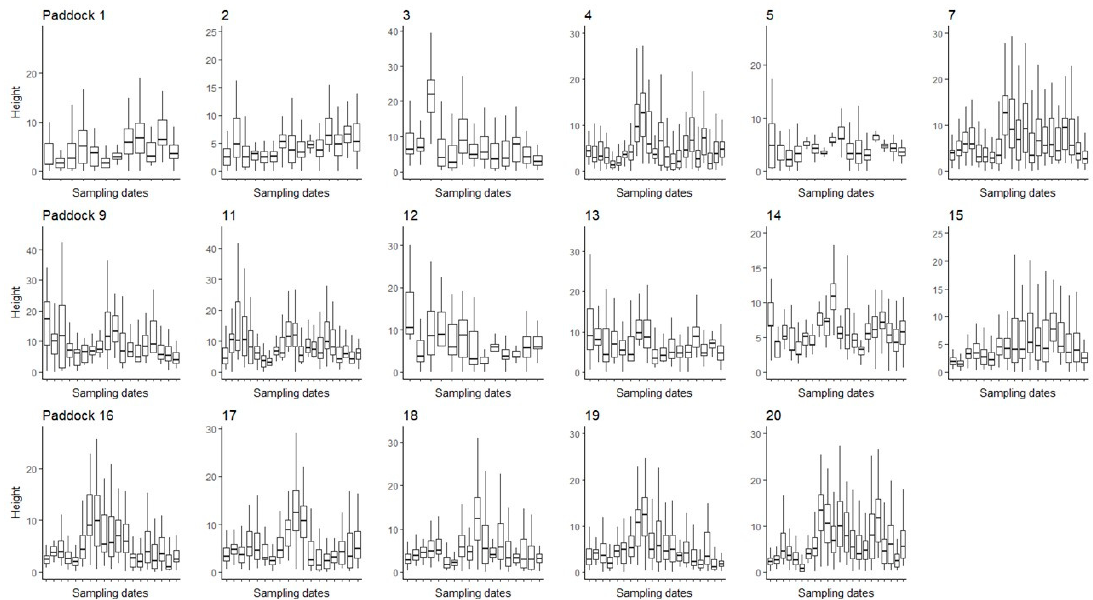
Figure 3. Height (cm) boxplot showing the distribution of observed data of each one of the 17 individually analyzed paddocks. Paddocks with less than 10 sample dates were discarded (paddock 6, 8, and 10). Sampling dates, from October 2012 to December 2015, are di ff erent according to each paddock.